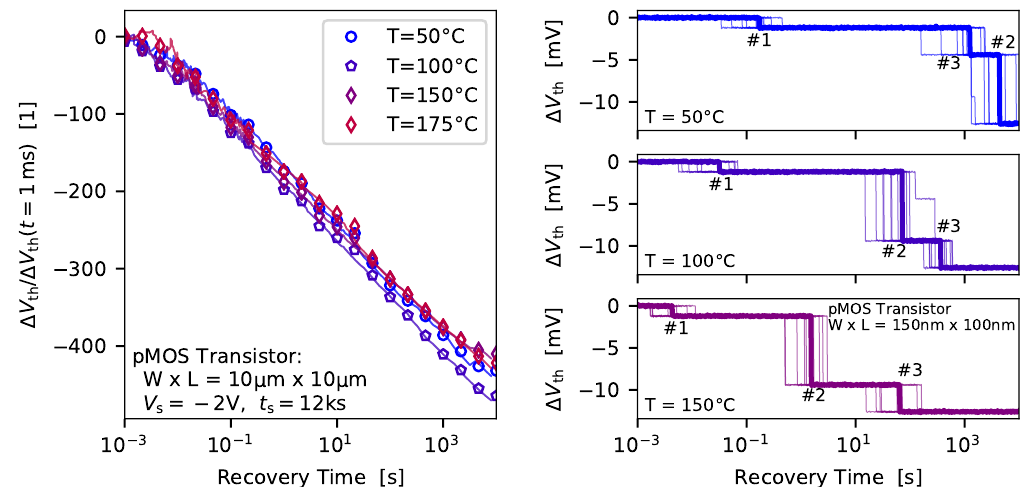
Figure 4. The temporal recovery behavior of a large-area and a nanoscale pMOS transistor is shown at different device temperatures. ( left ) Quite interestingly, the recovery traces of a large-area transistor can show only a very week temperature dependence when normalized to a certain reference value. ( right ) However, single-defect investigations clearly reveal a significant temperature dependence of charge trapping. Also shown here for the nanoscale device are the single recovery traces recorded at the same bias conditions, stress time and device temperature, which are used to determine the average emission time of the visible